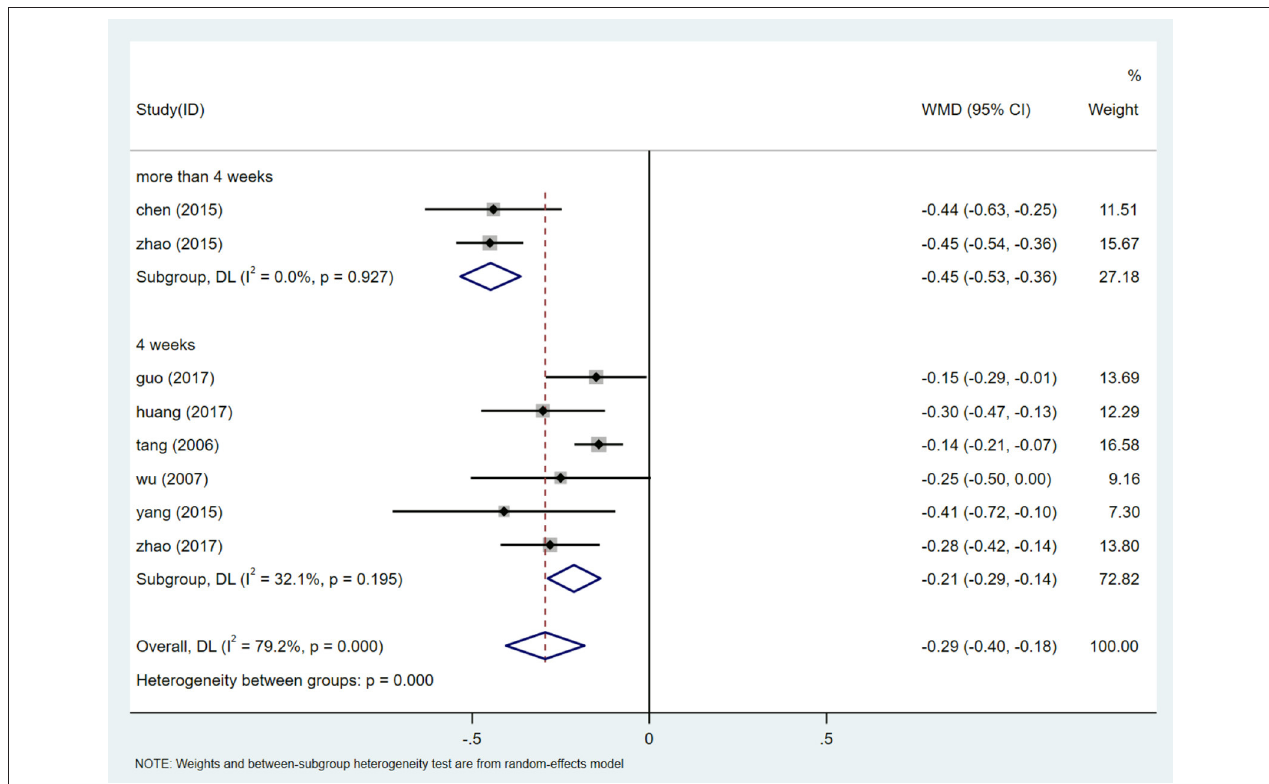
FIGURE 4 | Subgroups analysis of 24h